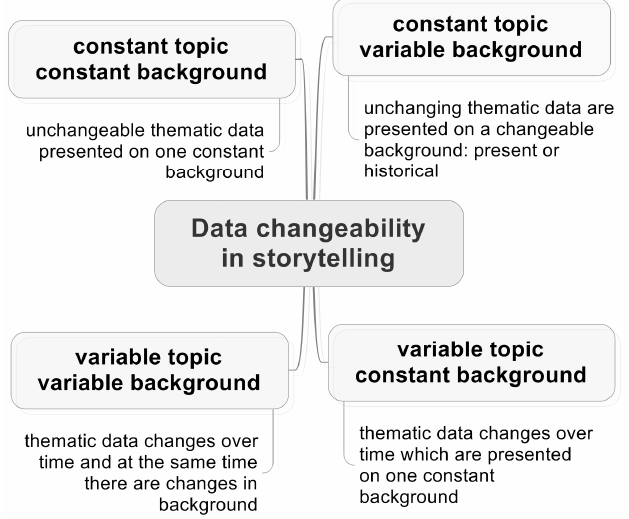
Figure 2. Possible combination of thematic and background data presentation (source: own study).